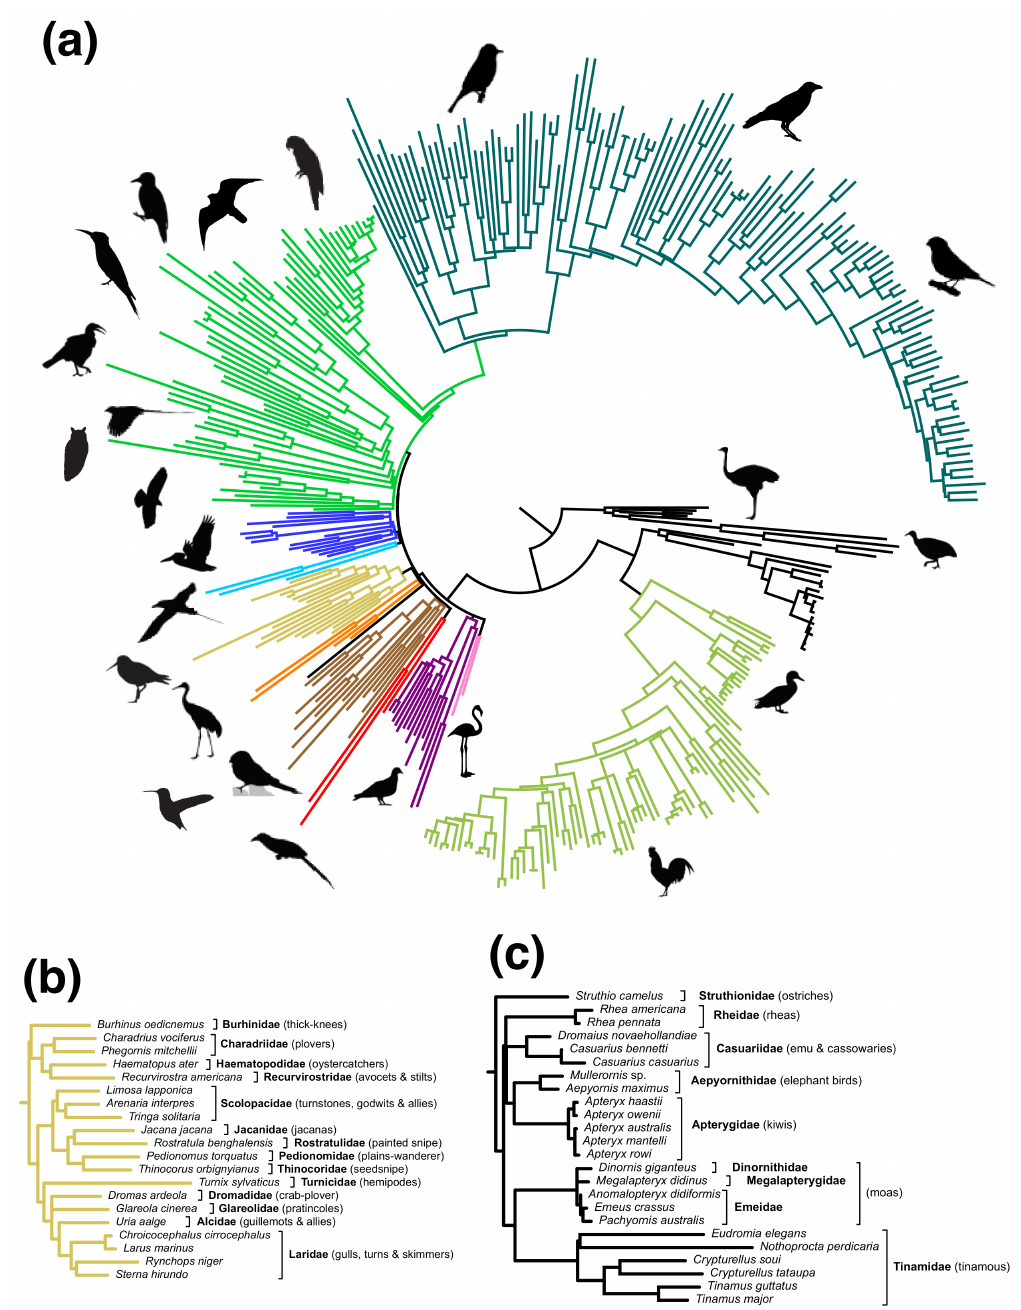
Figure5. Estimatesofbranchlengthsforthematrixrepresentationwithparsimony(MRP)phylogenomic supertree. Branch lengths reflect analysis of the mitochondrial genes cytochrome b and NADH dehydrogenase subunit 2 using the GTR + I + Γ model and six partitions (corresponding to the three codon positions within each gene). ( a ) Unlabeled tree based on reduced data matrix (taxa with > 25% missing data removed) with silhouettes to indicate major lineages. Colors are identical to those in Figure 3; a key to the color scheme is also available in Supplementary Materials. To emphasize the long branches for Turnicidae (hemipodes, also known as buttonquails) and Tinamiformes (tinamous) we include labeled subtrees for Charadriiformes ( b ) and Palaeognathae ( c ) extracted from the tree based on all data. A comparison of the Charadriiformes and Palaeognathae subtrees to similar trees based on nuclear sequence data is available in Supplementary